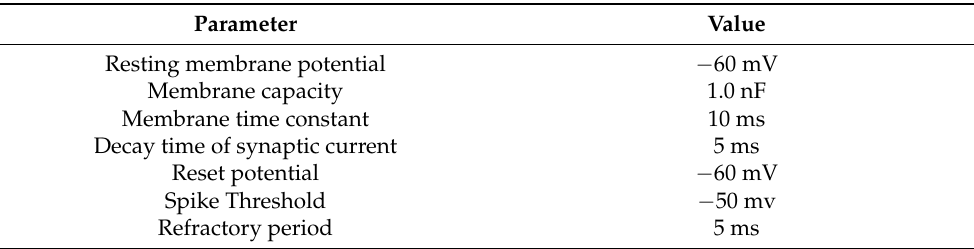
Table 1. Parameters of the IAF neuron model . Parameter